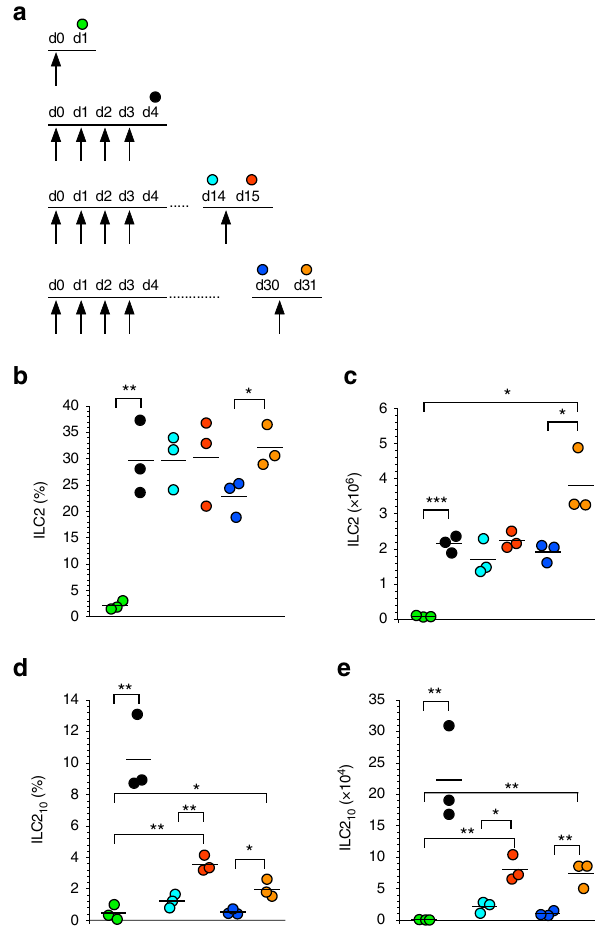
Fig. 4 ILC2 10 effector cells exhibit memory-like properties in vivo. a Timeline for ILC2 10 recall experiment using 10BiT reporter mice, with colors corresponding to day of cell analysis. Arrows indicate IL-33 injections. b – e Frequency ( b , d ) and number ( c , e ) of total ILC2 ( b , c ) or ILC2 10 ( d , e ) with experimental protocol in a . Data are from one experiment with three mice per group ( b – e ). ***P < 0.001, **P < 0.01, *P < 0.05 (Student ’ s t